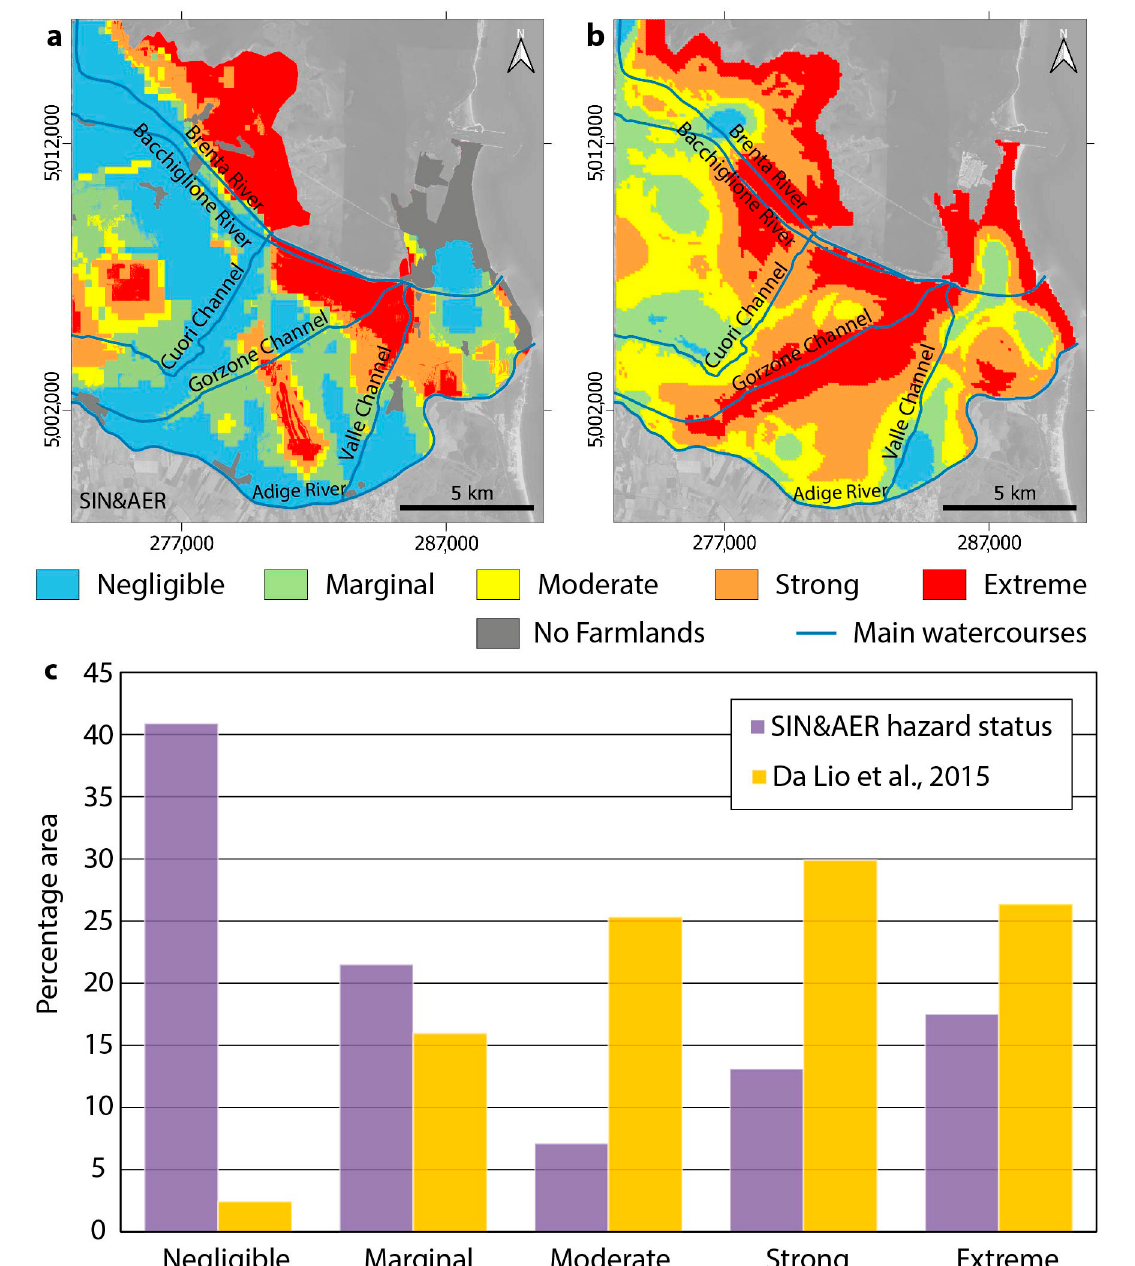
Figure 12. Maps of the vulnerability of farmlands to saltwater intrusion resulting from ( a ) this study and ( b ) Da Lio et al. [29]; ( c ) areal extent of the classes (%) for vulnerability status computed in the present study and by Da Lio et al. [29]. Coordinate system: UTM33,